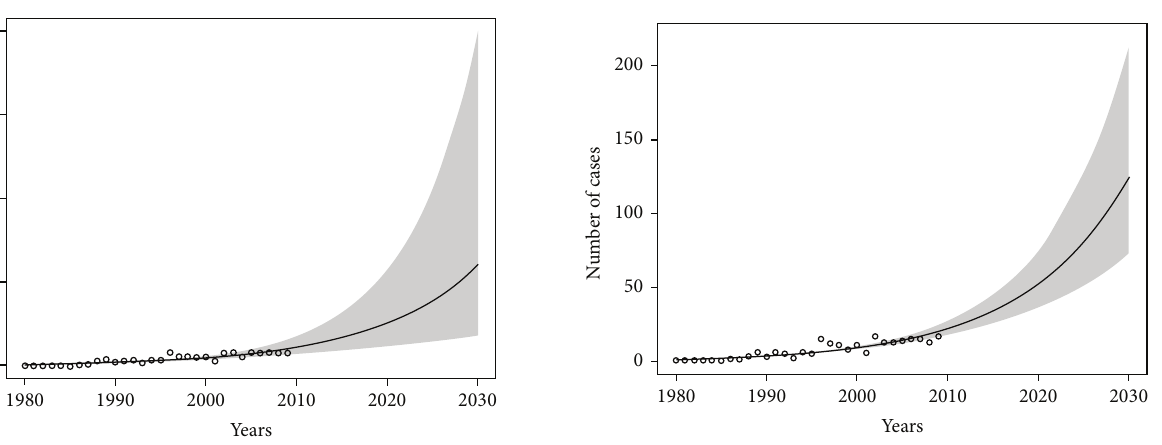
Figure 2: The forecast of increasing incidence of asbestos-related lung cancer in the zone number I until 2030. Significance level of model: 𝑃 < 0.01 .